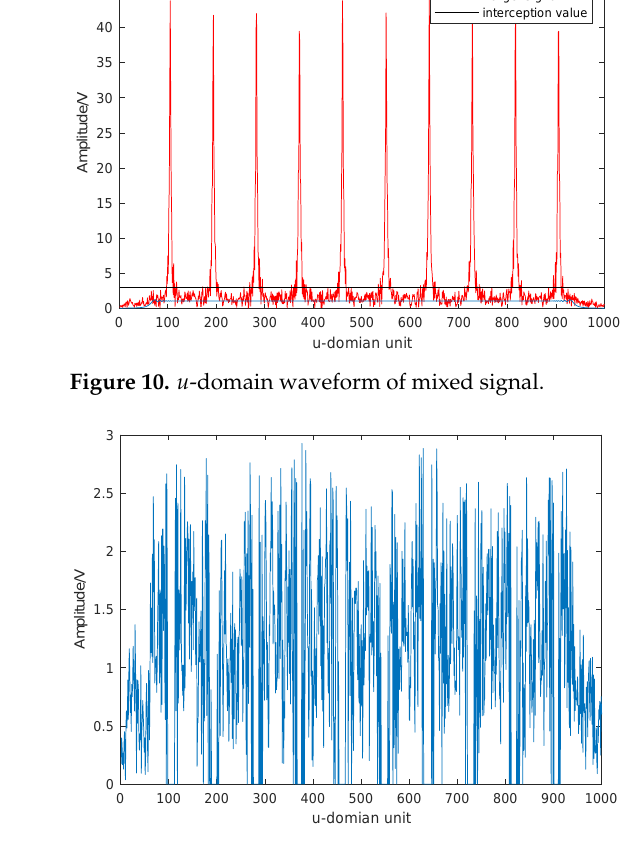
Figure 11. Cross-section diagram of u -domain waveform of mixed signal.